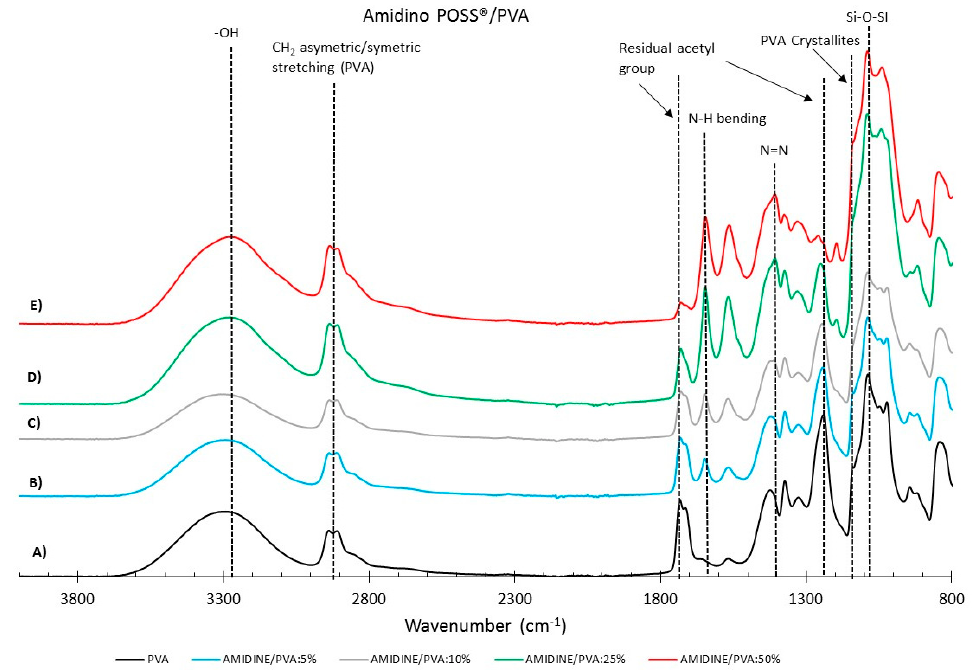
Figure 4. FTIR reflectance of (A) pure PVA, Amidino POSS ® /PVA: (B) 5%; (C) 10%; (D) 25%; (E) 50%. The curves are shifted vertically for clarity.